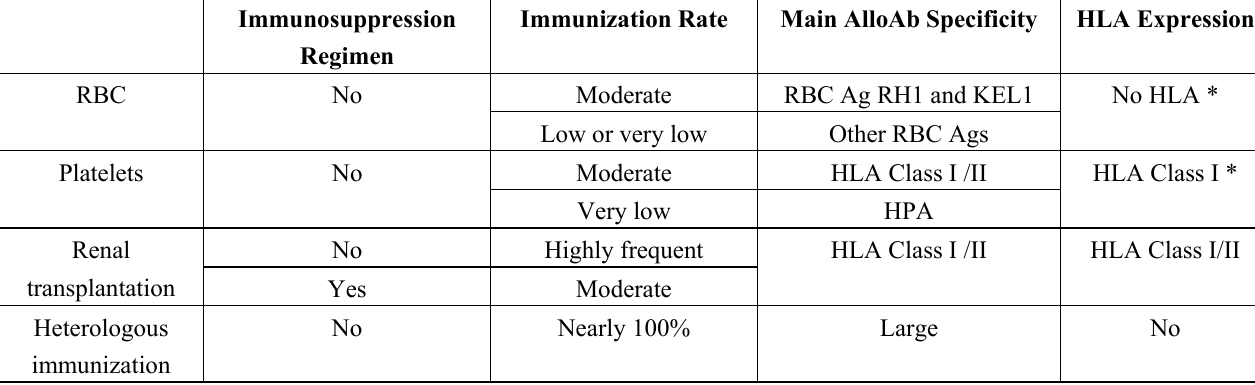
Table 1. Main alloimmunizations in clinical practice and comparison with heterologous